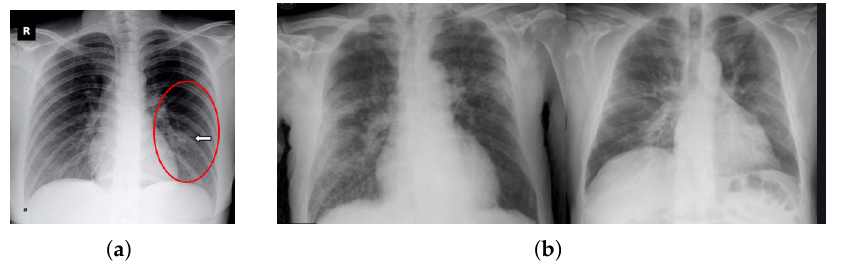
Figure 2. Sample chest X-ray. ( a ) Ground Glass Opacity found (Opacities of infrahilar airspace were found right side in the red circle of COVID-19 patient) [20]. ( b )